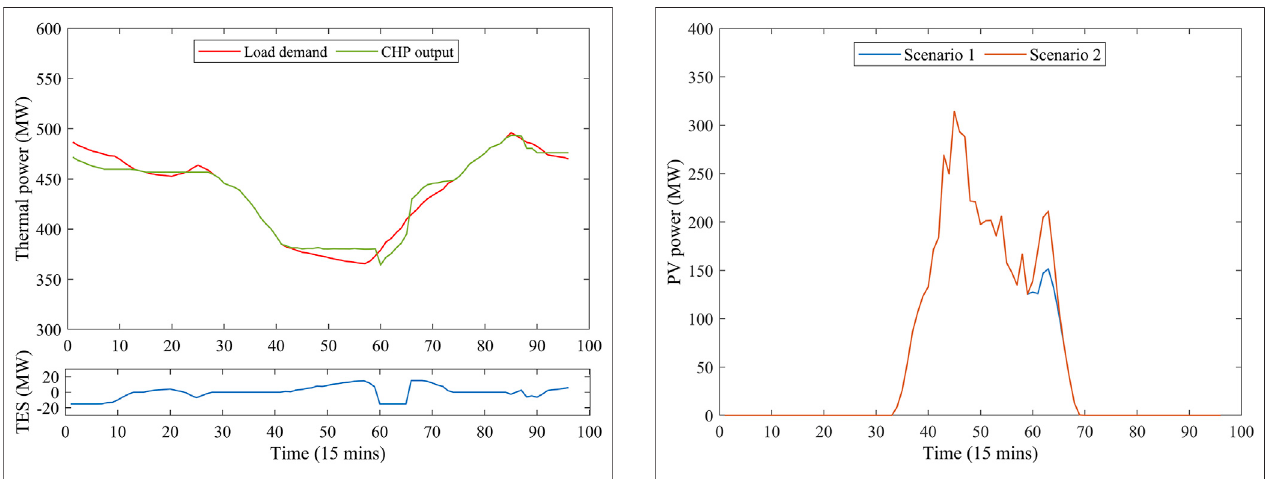
FIGURE 8 | Thermal power of demand and supply.